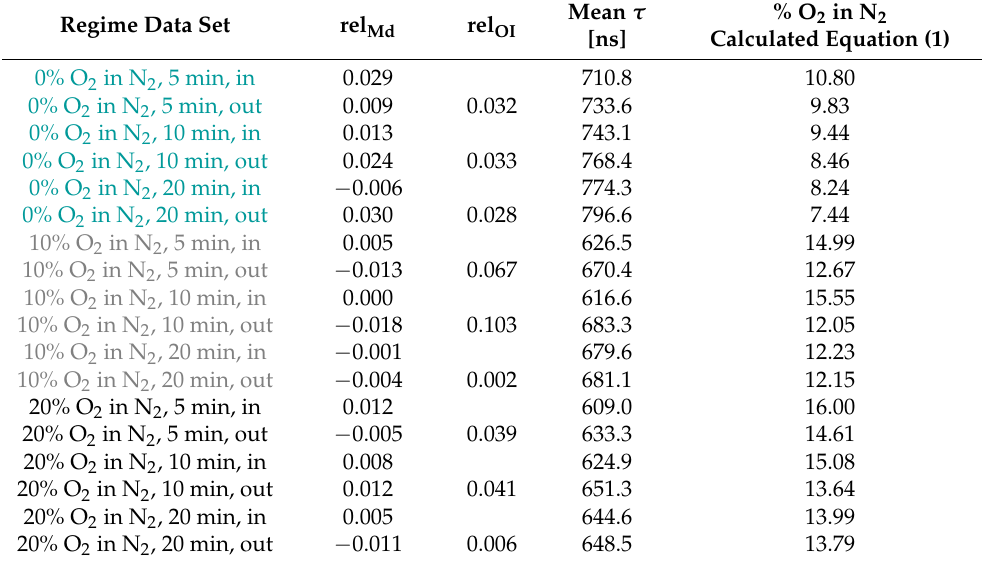
Table 1. Additional information on descriptive statistics of [Ru(Phen) 3 ] 2+ luminescence lifetimes corresponding to different experimental conditions in the CAM. To clarify the meaning of the symbols used in the table headings, please refer to their meanings below in Equations (1)–(3). The color code is the same as in dendrograms in Figures 3 and